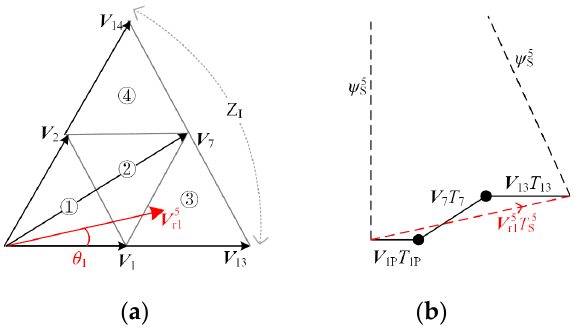
Figure 5. Relationship between space vector and flux trajectories. ( a ) V 5 trajectories change in subcycle.